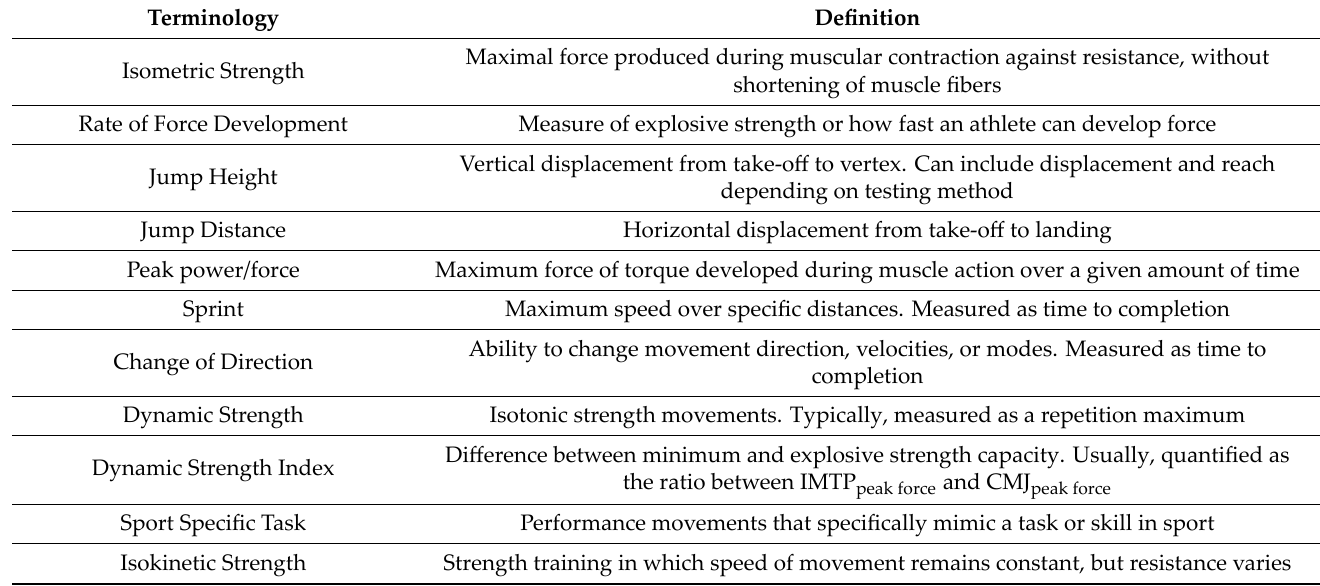
Table 2. Definitions of categories of outcome variables used to characterize distribution of studies